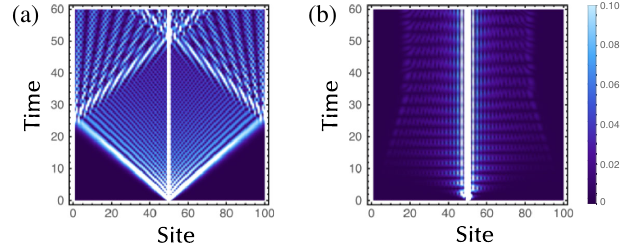
FIG. 3. Correlation propagation in the Hatano-Nelson model with open boundaries ( L ¼ 100 , J ¼ 1 . 0 ) for (a) γ ¼ 0 . 0 and (b) γ ¼ 0 . 8 . The absolute values j C l;l j of the correlation matrix 0 are shown as a function of site l and time t with l 0 ¼ L= 2 ¼ 50 . The initial state is prepared as the charge density wave state in Eq. (4). In the presence of non-Hermiticity, the correlation propagation is frozen as a consequence of the non-Hermitian skin effect.